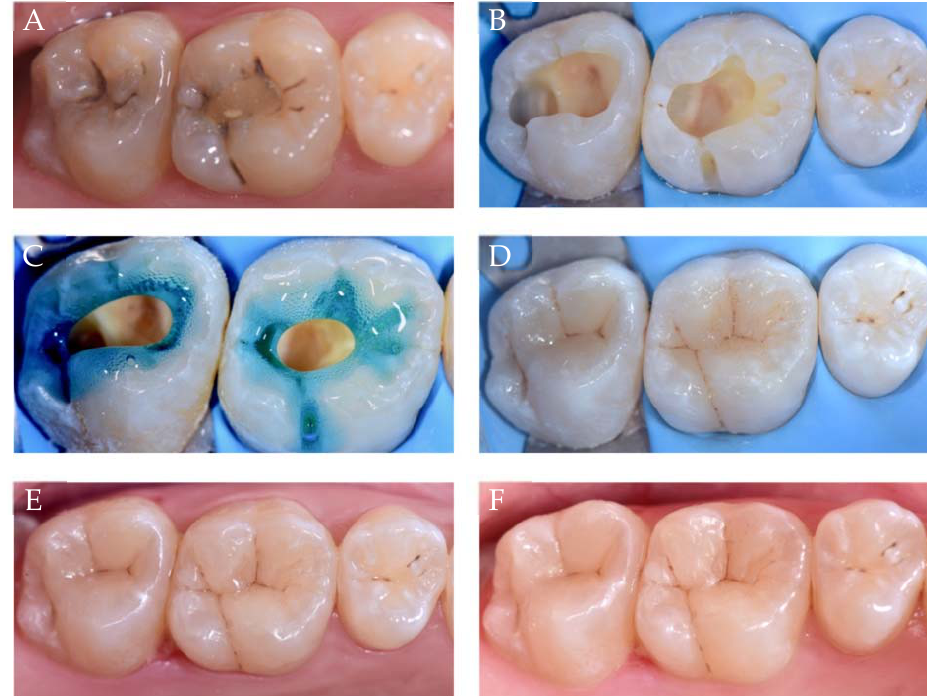
Figure 2. Description of FMBT and CULT on two class I cavities, where 16 shows the FMBT and 17 shows the CULT. ( A ) Preoperative situation; ( B ) cavity preparation and rubber dam placement; ( C ) phosphoric acid applied first on enamel before being applied on dentin; ( D ) FMBT on 16 and CULT on 17, and some stains were applied to give the restoration a 3D effect; ( E ) immediately after finishing and polishing; and ( F ) 1 year follow ‐ up.